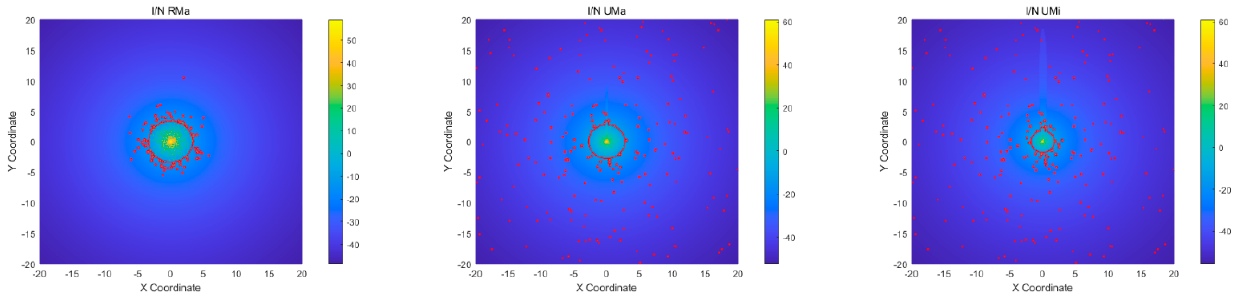
Figure 19. RMa, UMa, and UMi scenarios with an ES antenna elevation angle of 48° for the conventional omnidirectional antenna.